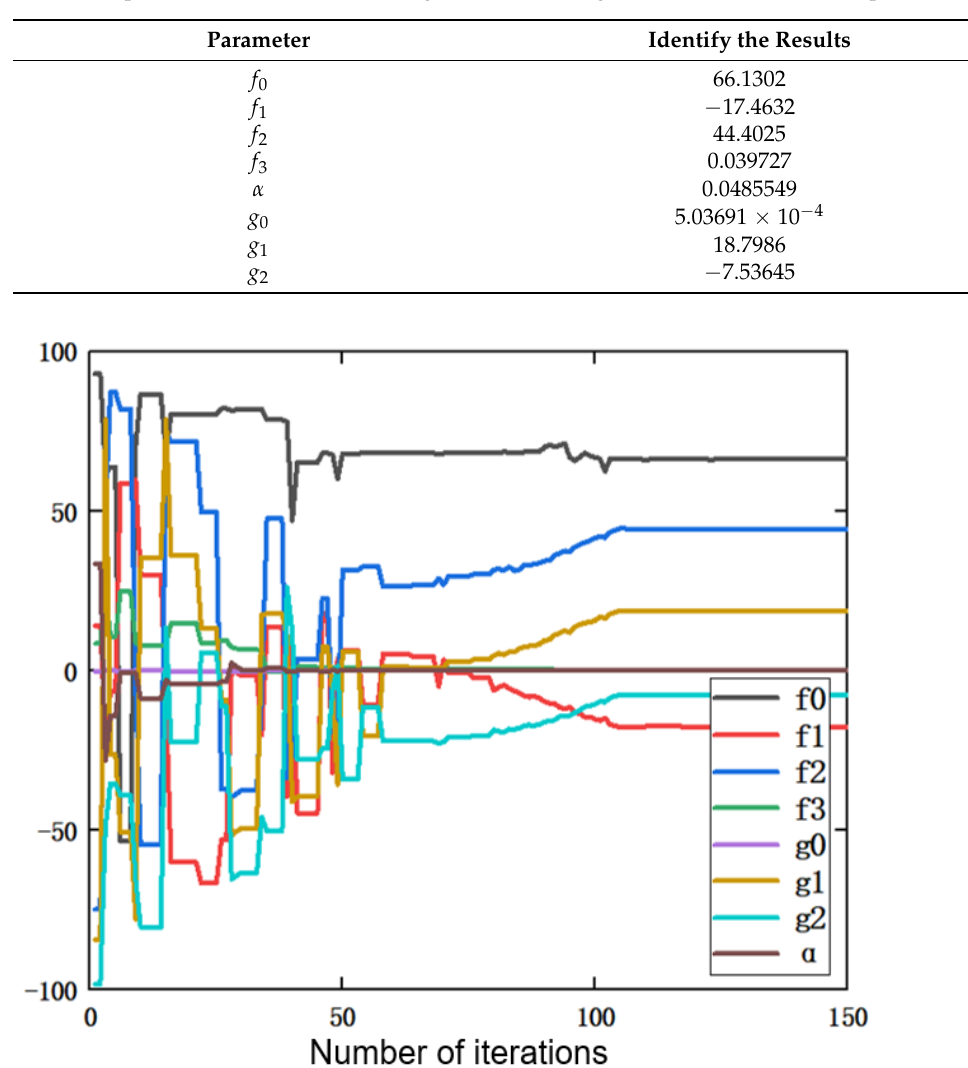
Figure 5. Improved parameter convergence process of artificial fish swarm algorithm model.